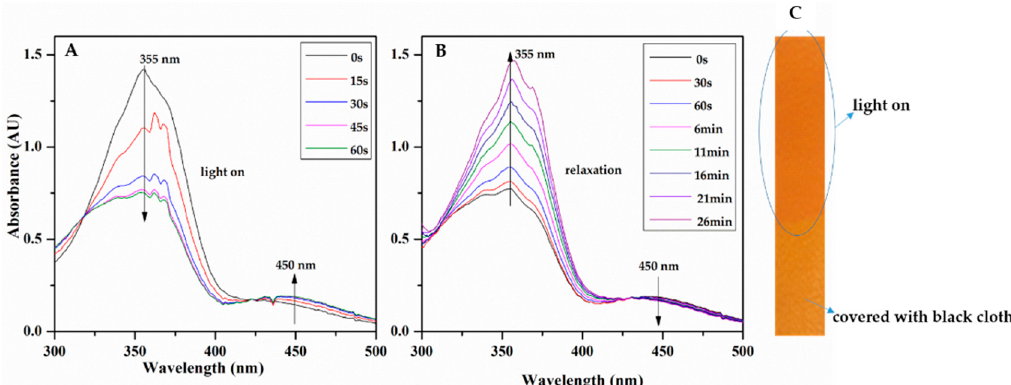
Figure 8. The light-responsive behavior of the MMAZO in ethanol ( A and B ) and the PMMAZO-graft CNCs and polyurethane composite film ( C ).